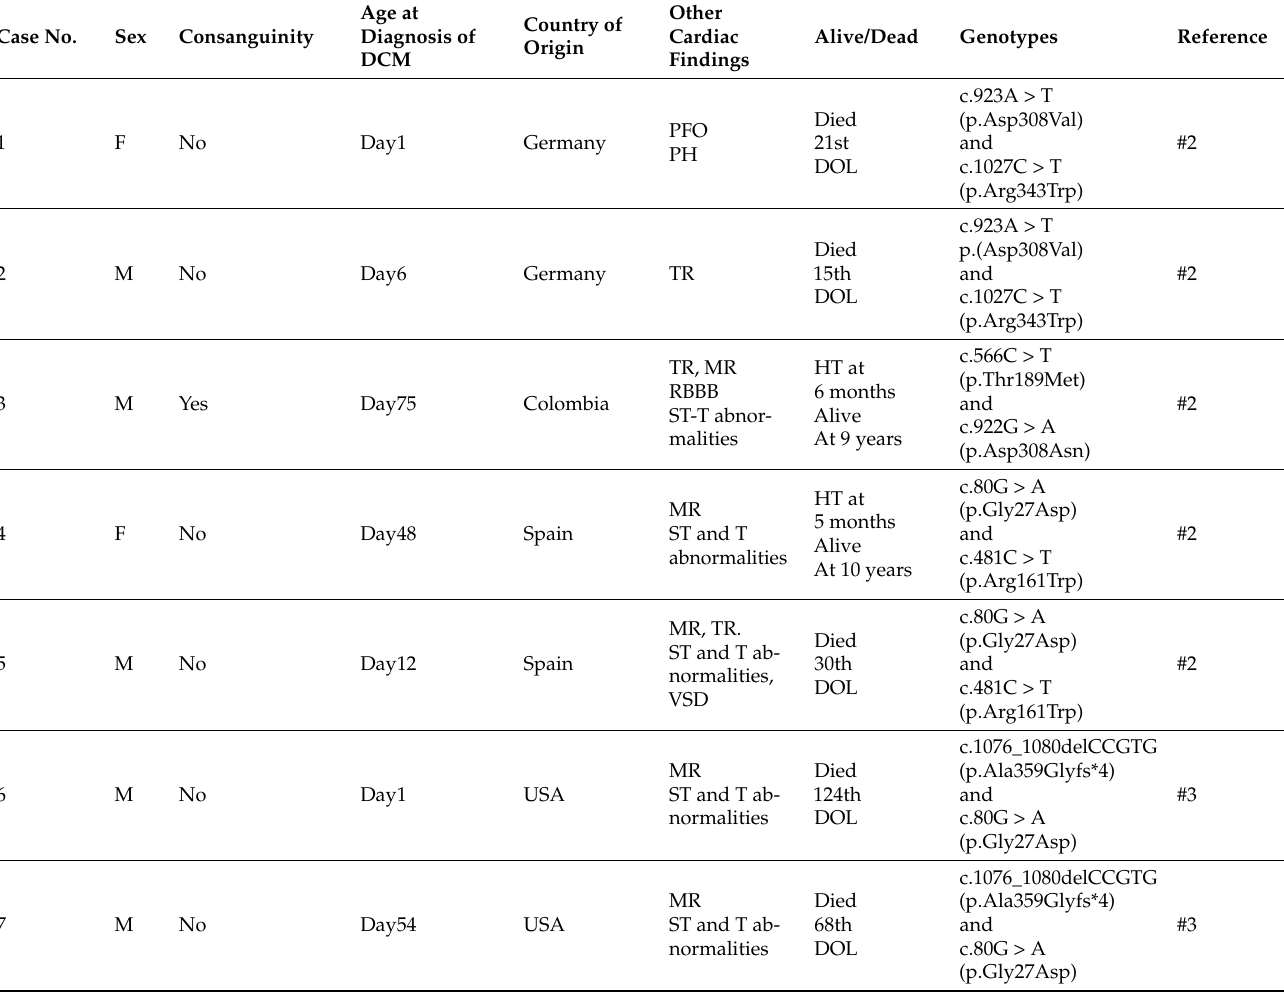
Table 1. Clinical and genetic findings in seven patients with homozygous variants of the RPL3L gene diagnosed using whole exosome sequencing and associated with severe DCM reported in the literature (this table is modified from our earlier publication